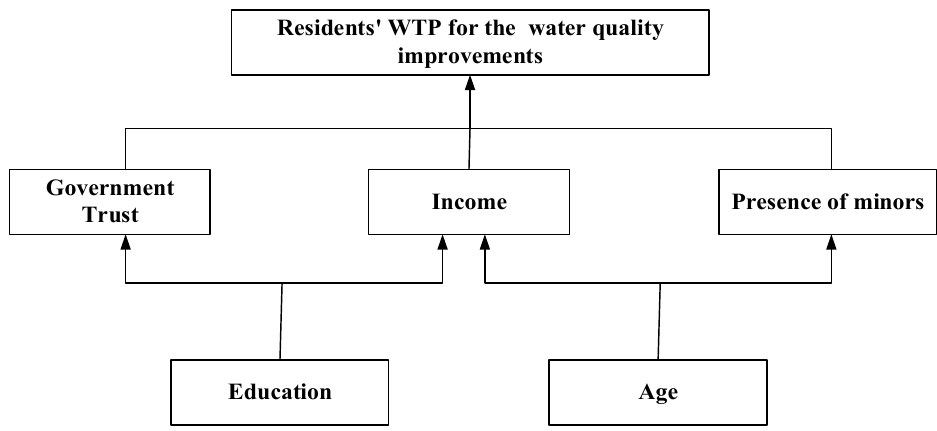
Figure 4. Interpretative Structural Model of the In fl uencing